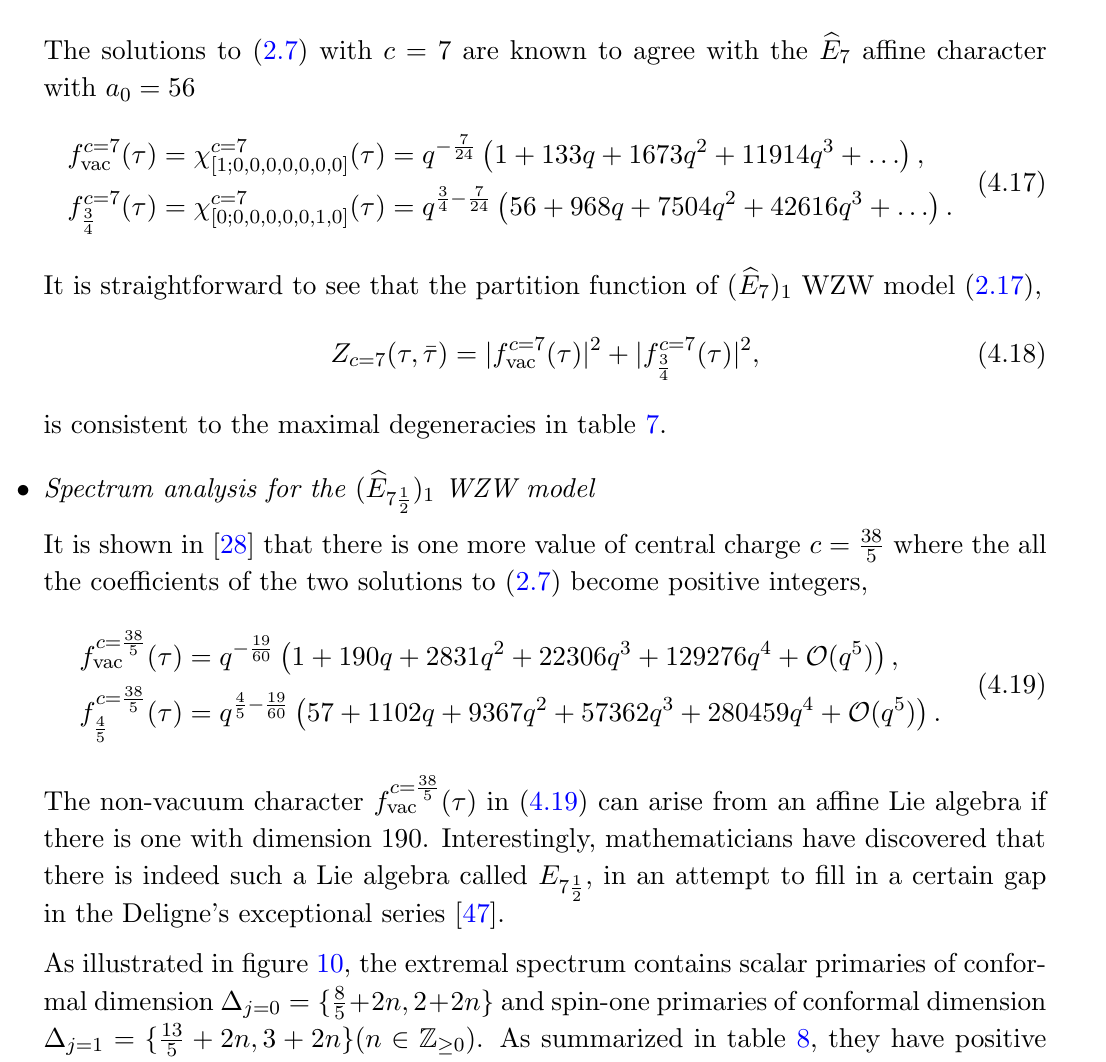
a(cid:14)ne character 7